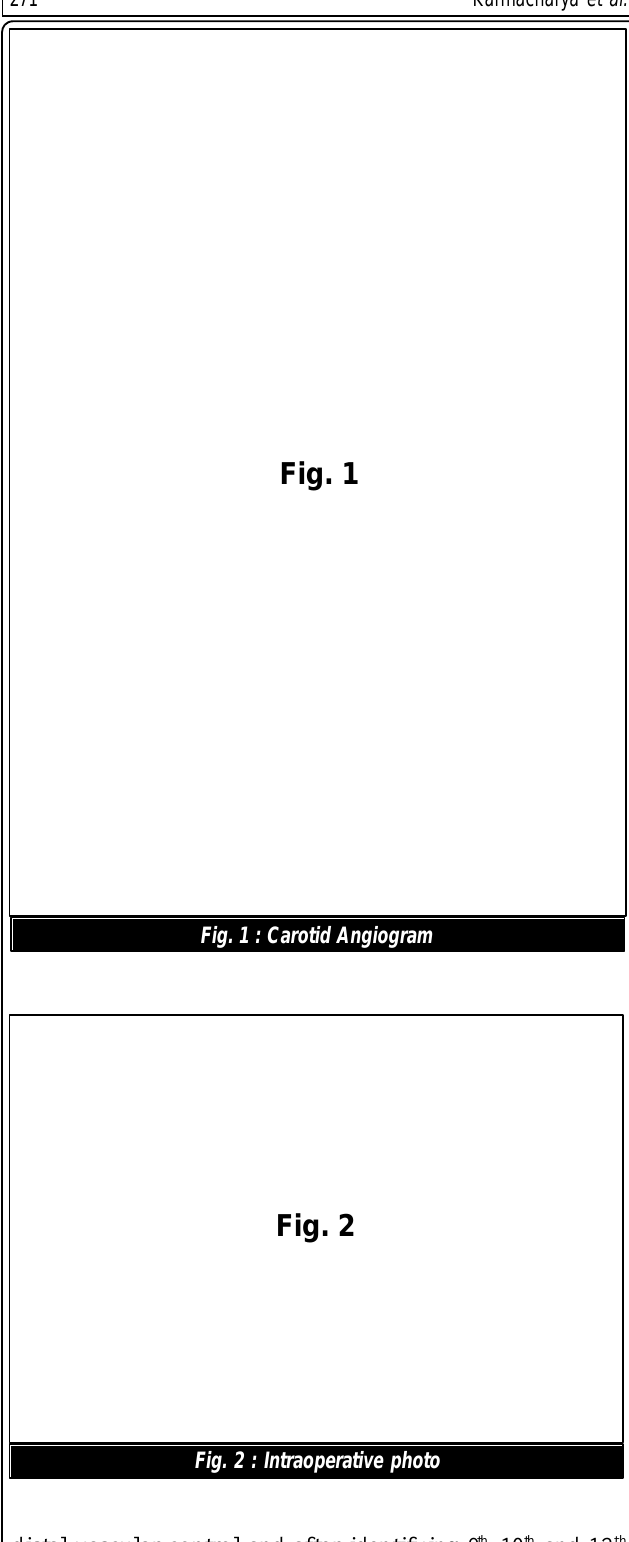
Fig. 2 : Intraoperative photo